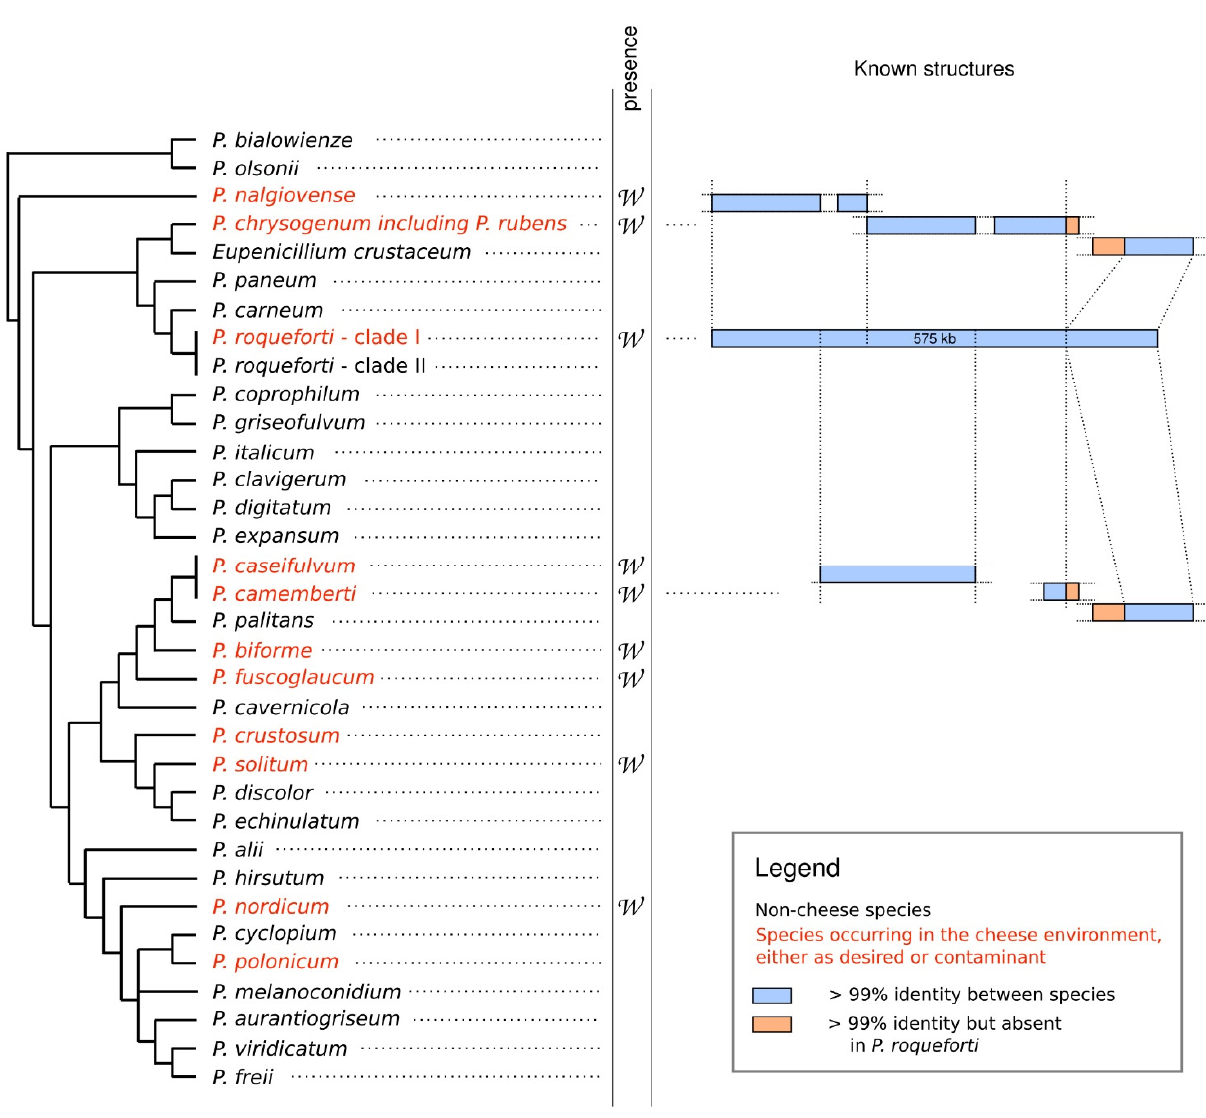
FIGURE 1: Phylogeny of Penicillium species screened by PCR for the presence of Wallaby. Several species occurring in the cheese environ- ment (in red), either as desired or contaminant species, carry Wallaby. The structure of Wallaby is represented on the right hand side: the 575 Kb genomic island is in a single block in P. roqueforti (blue bar in the middle) while it is fragmented and located in non-homologous re- gions in P. camemberti (below) and P. rubens